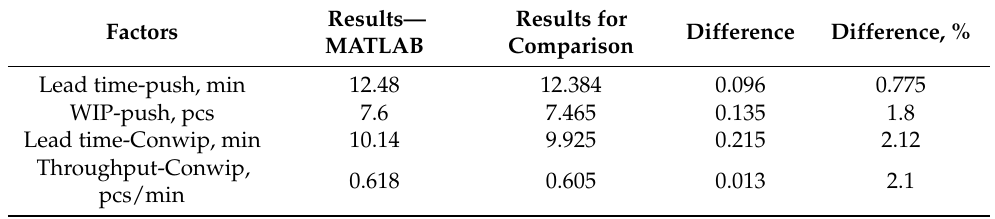
Table 1. Validation of push and Conwip